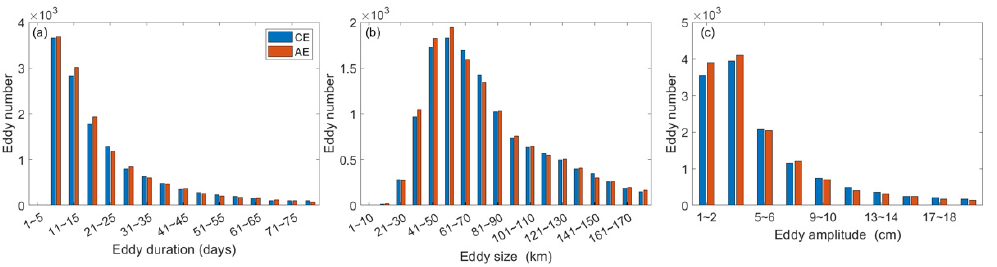
Figure 3. Histogram of the ( a ) lifespan, ( b ) maximum size, and ( c ) maximum amplitude for cyclonic and anticyclonic eddies in their